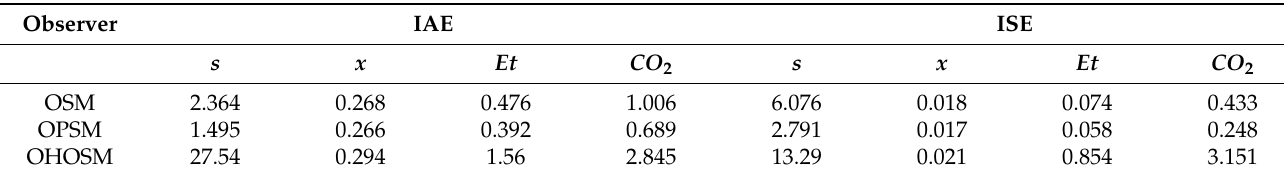
Table 6. Real-time estimation error.